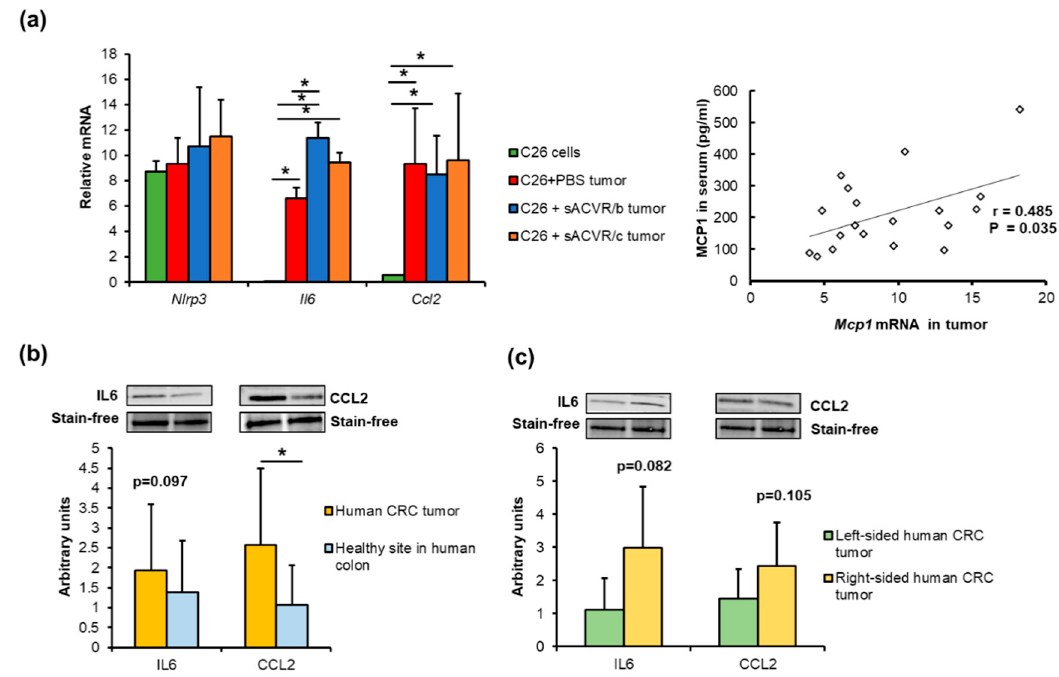
Figure 6. ( a ) Compared to the non-implanted C26 cancer cells, mouse C26 tumors expressed more CCL2 and IL6, independent of the sACVR treatment. The expression of CCL2/MCP-1 in the tumors was associated with the level of MCP-1 in sera. ( b ) Human CRC tumors ( n = 13) expressed more CCL2 than the healthy colon sites. ( c ) The right-sided tumors ( n = 6) tended to have higher expression levels of IL6 and CCL2 than the left-sided tumors ( n = 7). * Denotes a statistically significant difference between the groups that are connected with lines. Control (CTRL, n = 9), cancer (C26 + PBS, n = 7), the group that received sACVR2B until tumor formation (C26 + sACVR/b, n = 7), and the group that received sACVR2B until death (C26 + sACVR/c, n = 8).